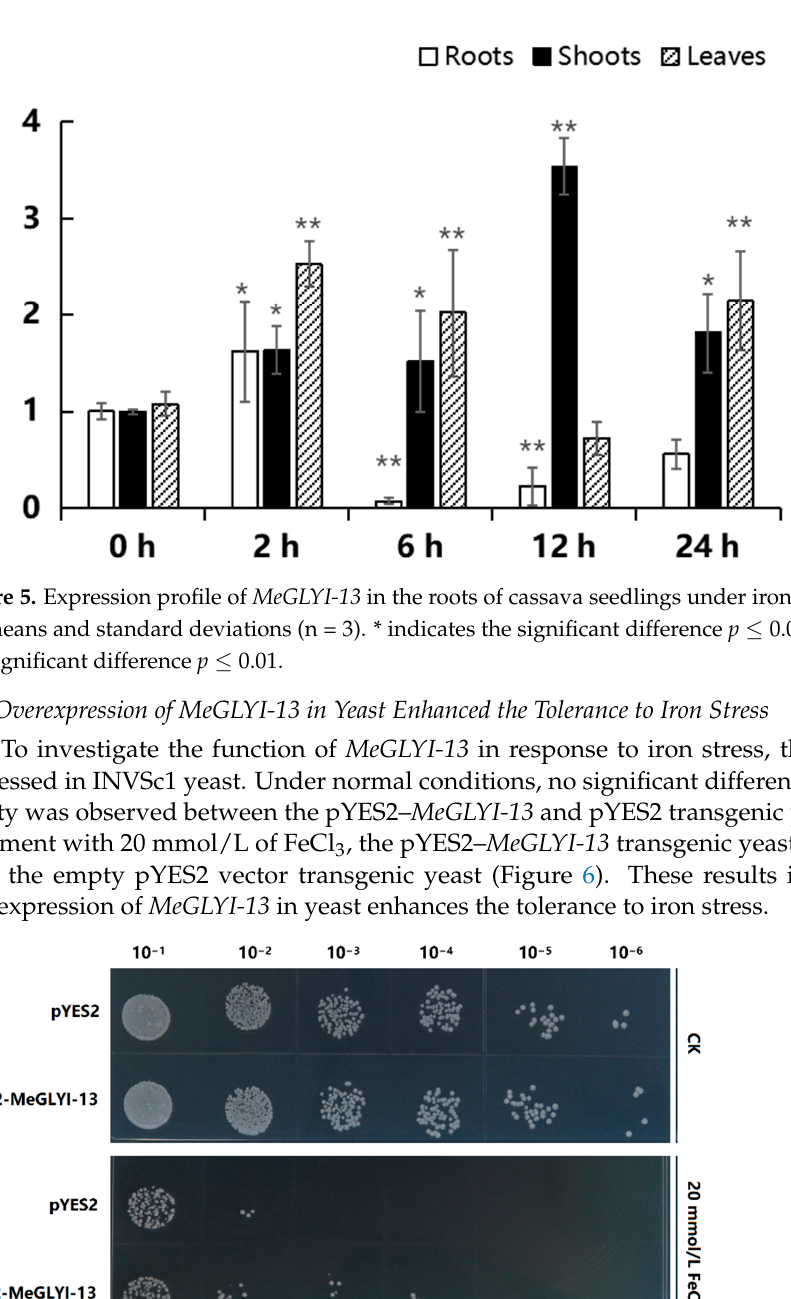
6 of 13 Figure 4. Expression analysis of the MeGLYI family genes in 11 tissues. OES, organized embryo- genic structure; FEC, friable embryo callus; RAM, root apical meristem; SR, storage root; FR, fibrous root; S, stem; SAM, shoot apical meristem; LB, lateral bud; P, petiole; M, midvein; L, leaf. 2.3. Expression of MeGLYI-13 in Response to Iron Stress Since MeGLYI-13 is preferentially expressed in young tissues and organs, we were curious to analyze whether it is involved in the stress response to iron. Cassava tissue culture seedlings at the one-month stage were subjected to treatment of 450 μ mol/L of FeCl 3 for 0, 2, 4, 6, 8, 12, and 24 h, separately. The mRNA levels of MeGLYI-13 expressed in the roots, shoots, and leaves were analyzed by qRT-PCR. Under high-iron treatment, the expression of MeGLYI-13 in the roots increased significantly at 2 h, but decreased sig-